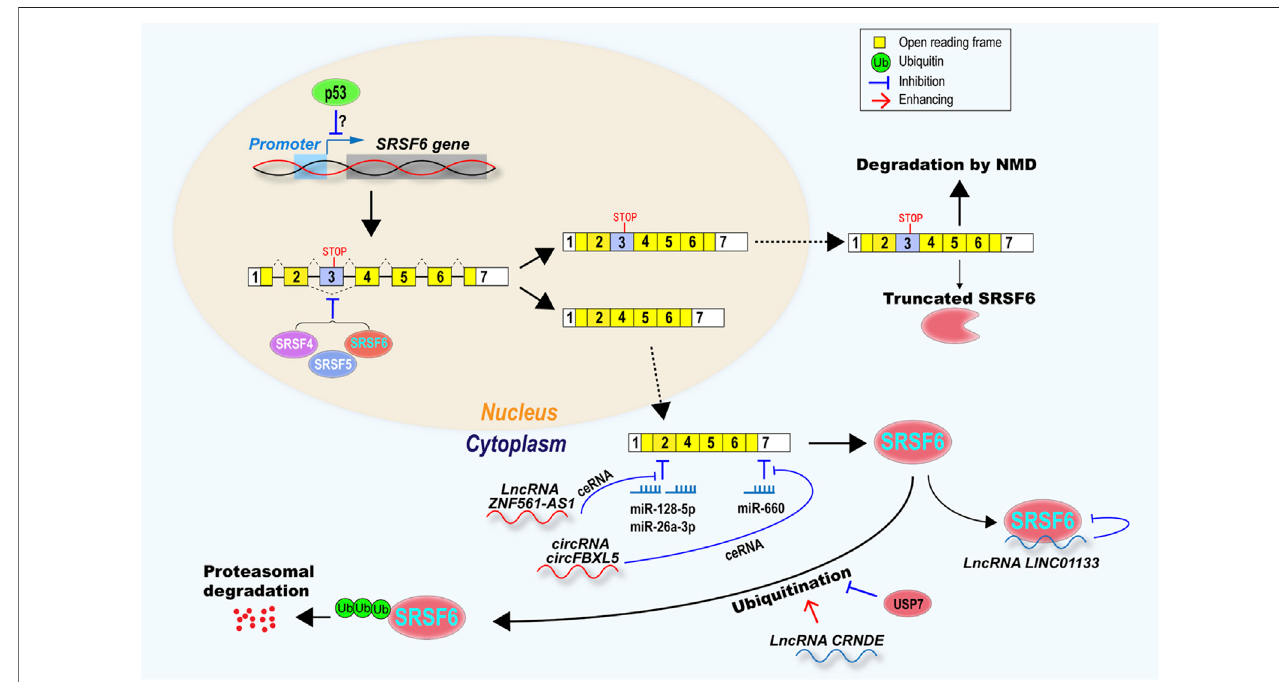
FIGURE 3 | SRSF6 expression and function were regulated at multiple levels, including transcription, alternative splicing, mRNA stability, protein stability and function. Tumor suppressor p53 may inhibit SRSF6 transcription. SRSF6 itself, SRSF4, and SRSF5 inhibit SRSF6 exon 3 exclusion to produce a transcript with exon 3, whichisatargetofNMDorencodeatruncatedSRSF6protein.Transcriptswithoutexon3encodefull-lengthSRSF6,andwereinhibitedbymicroRNAmiR-128-5p,miR- 26a-3p, and miR-66a, but rescued by lncRNA ZNF561-AS1, circRNA circFBXL5 via ceRNA mechanism. SRSF6 protein can be suppressed by lncRNA LINC01133. SRSF6 can be degraded via ubiquitination-proteasome. LncRNA CRNDE promotes SRSF6 ubiquitination, however, USP7 deubiquitinase can protect SRSF6 from ubiquitination and